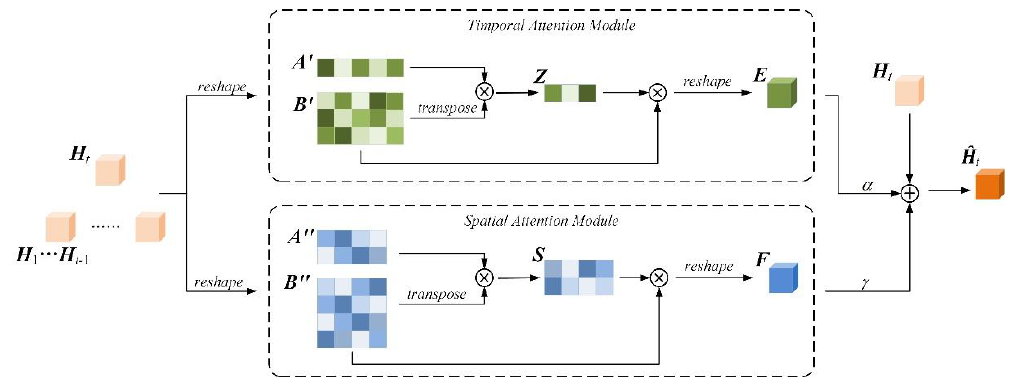
Figure 3. Dual attention module.